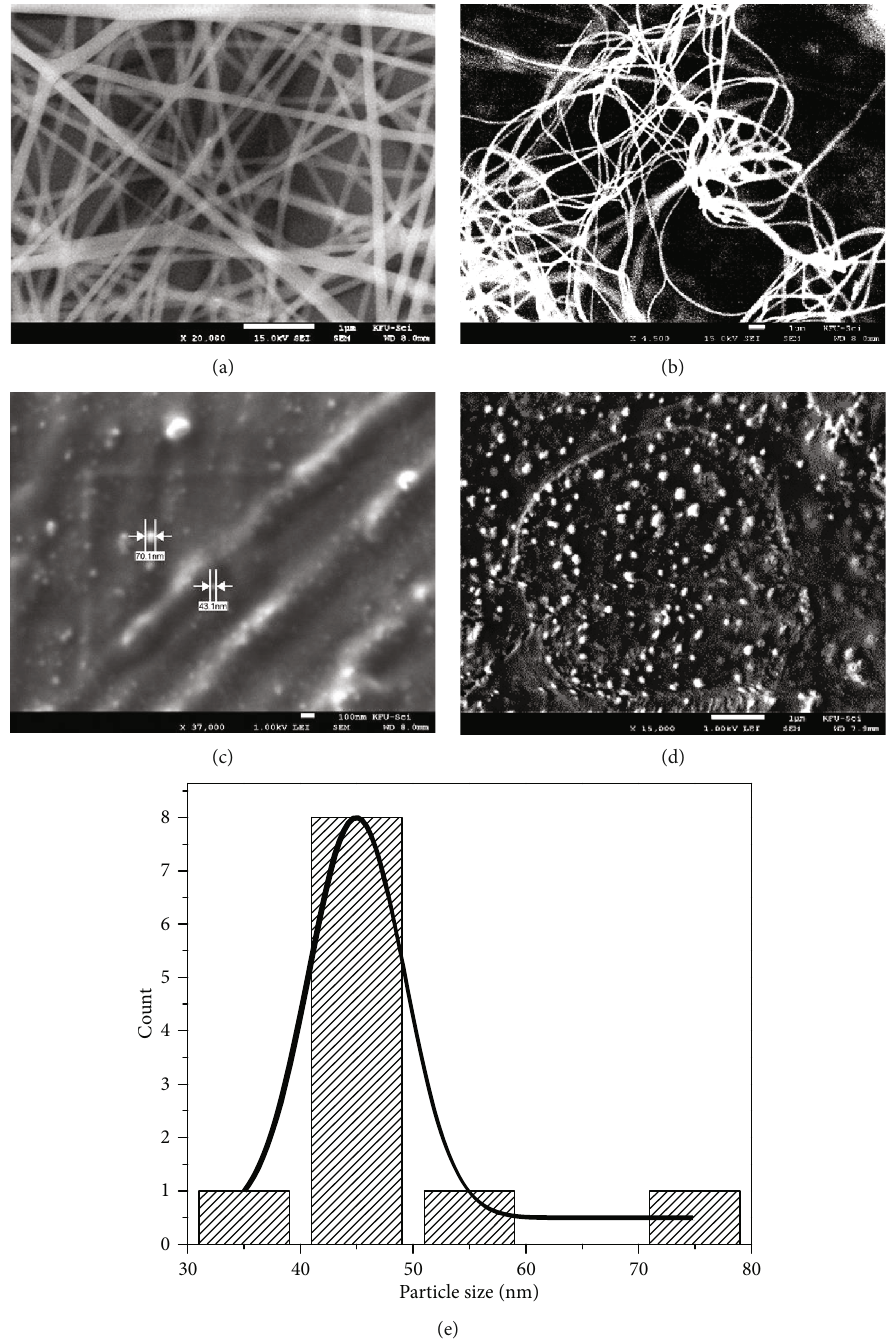
Figure 4: (a) Scanning electron microscopy image of electrospun fi bers of PVA and LDH fi llers dried at 75 ° C (PF75). (b) Scanning electron microscopy image of annealed fi bers of PVA and LDH fi llers (CF250). (c) High-resolution image showing individual ZnO nanoparticle fi llers inside the fi bers. (d) High-resolution image of the dispersion of nanoparticles inside the PVA matrix. (e) Dispersion of the nanoparticles is centered at 45nm, and the size distribution fi ts a Gaussian curve with a full width at half maximum of ~